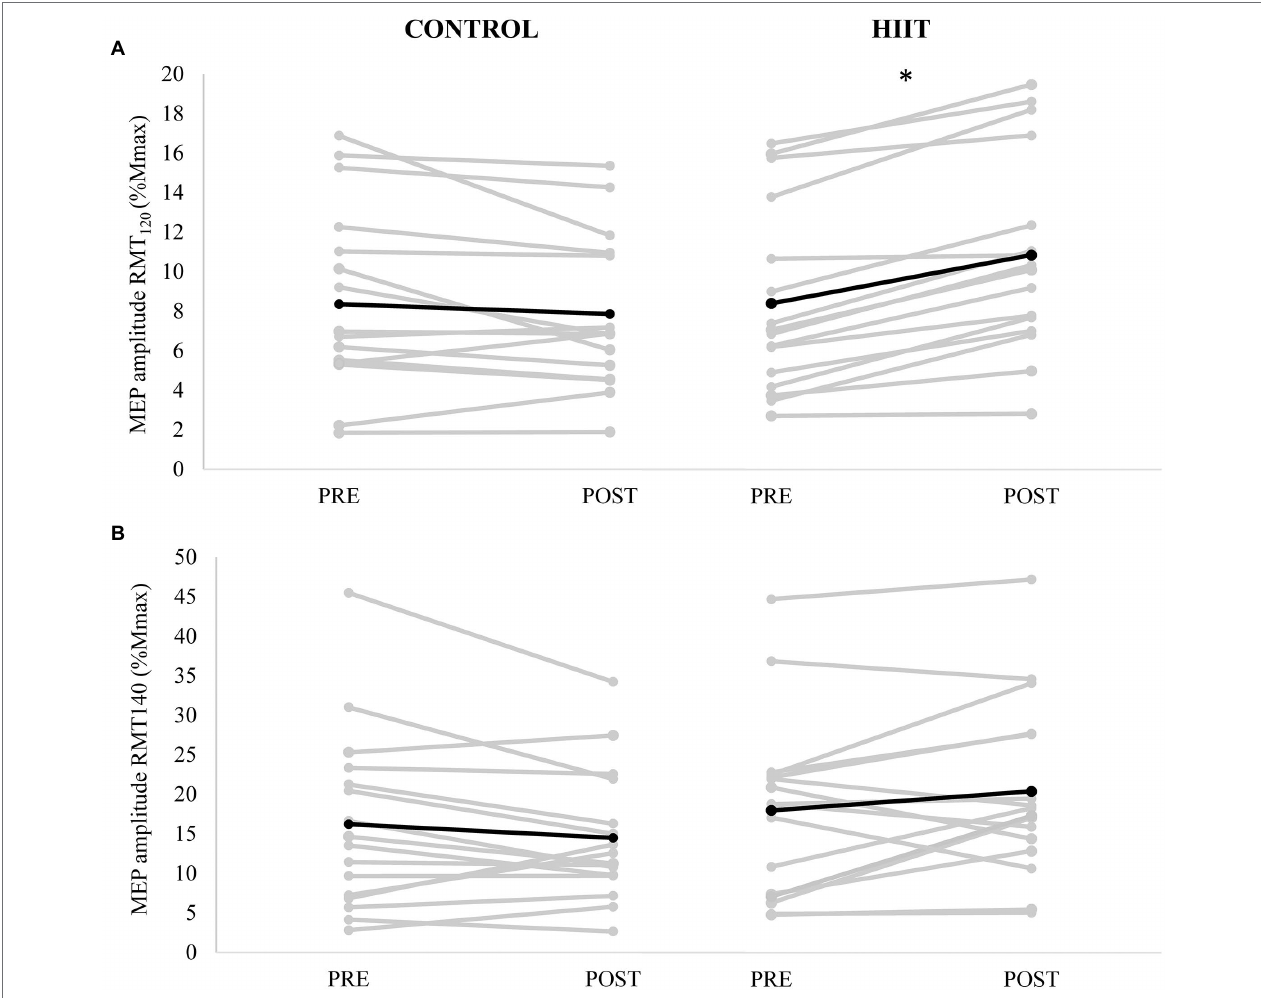
FIGURE 1 | Motor evoked potential (MEP) amplitude (mV) evoked at (A) 120% resting motor threshold (RMT) and (B) 140% RMT measured PRE and POST for each participant (gray lines) with control condition shown in the left panels, and HIIT shown on the right panels. The mean amplitude for each condition is depicted by the black line. * denotes a significant condition × time interaction ( p <